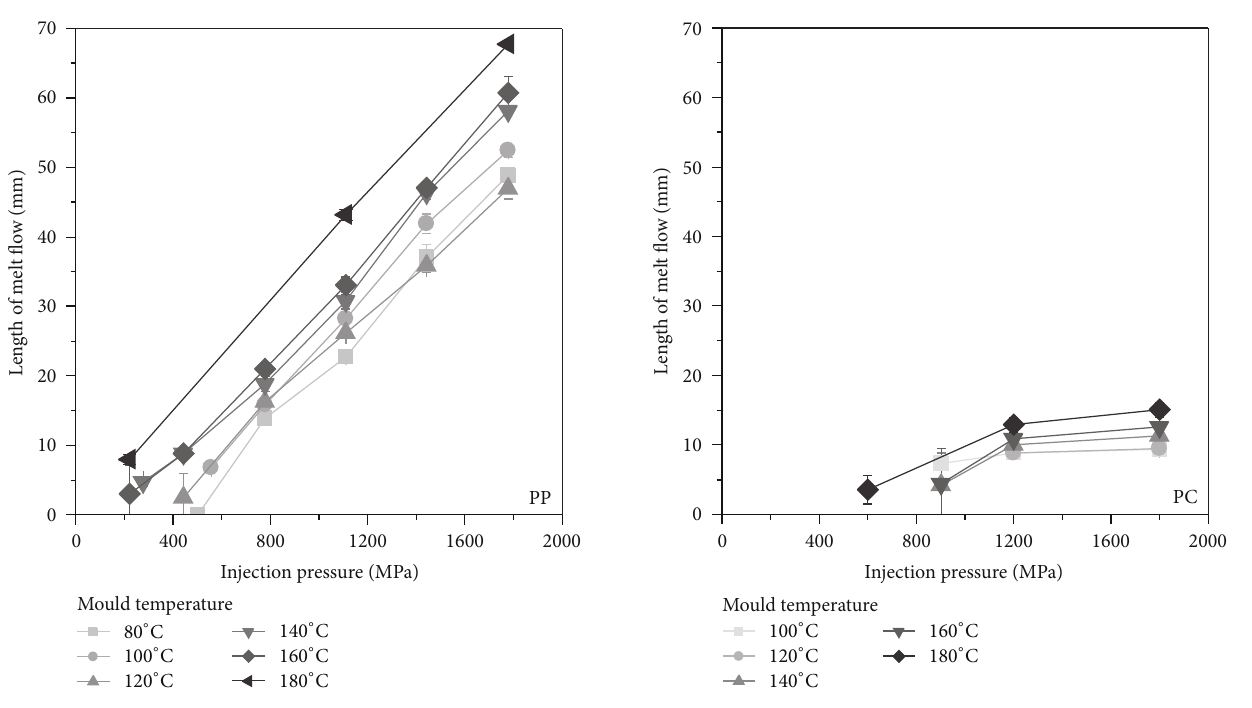
Figure 5: Flow length as function of injection pressure and mould temperature for PP.